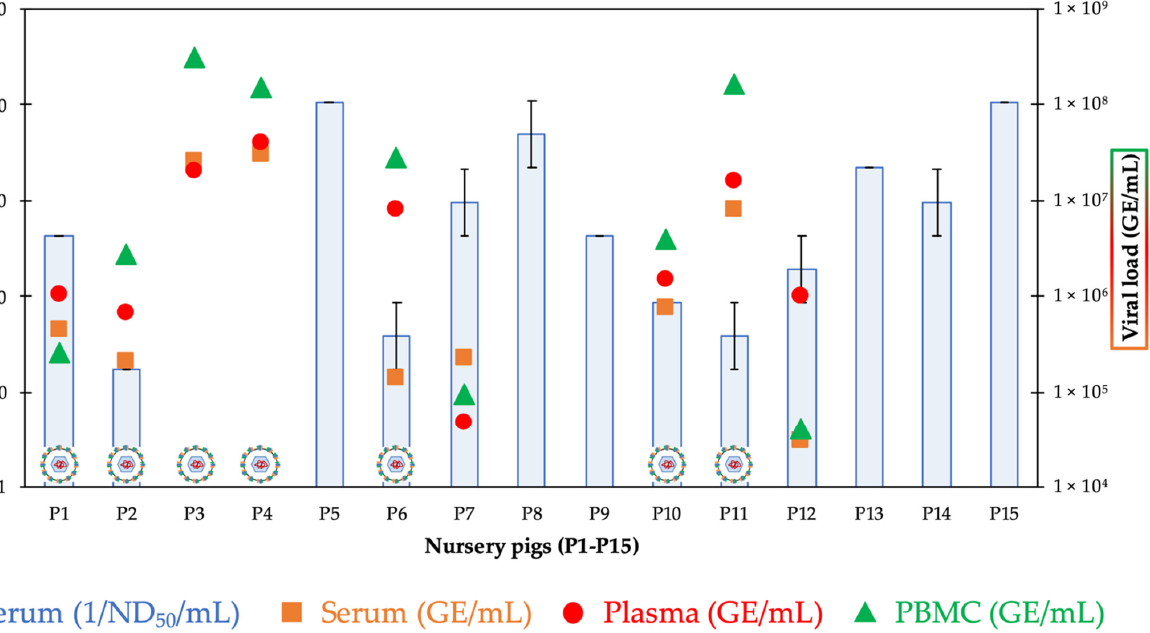
Figure 2. Results of the serum virus neutralization (SVN) assay (ND 50 /mL), the LindaV-specific RT-qPCR assay from serum, plasma and PBMCs (GE/mL), and virus isolation from PBMCs of six-week-old nursery pigs (P1–P15). Virus particles represent successful virus isolation through co-culturing of PBMCs with SK-6 cells. Neutralizing antibody titers are given as the reciprocal ND 50 value and error bars indicate positive and negative standard deviations. ND 50 , 50% neutralization dose; GE, genome equivalents; PBMC, peripheral blood mononuclear cell.